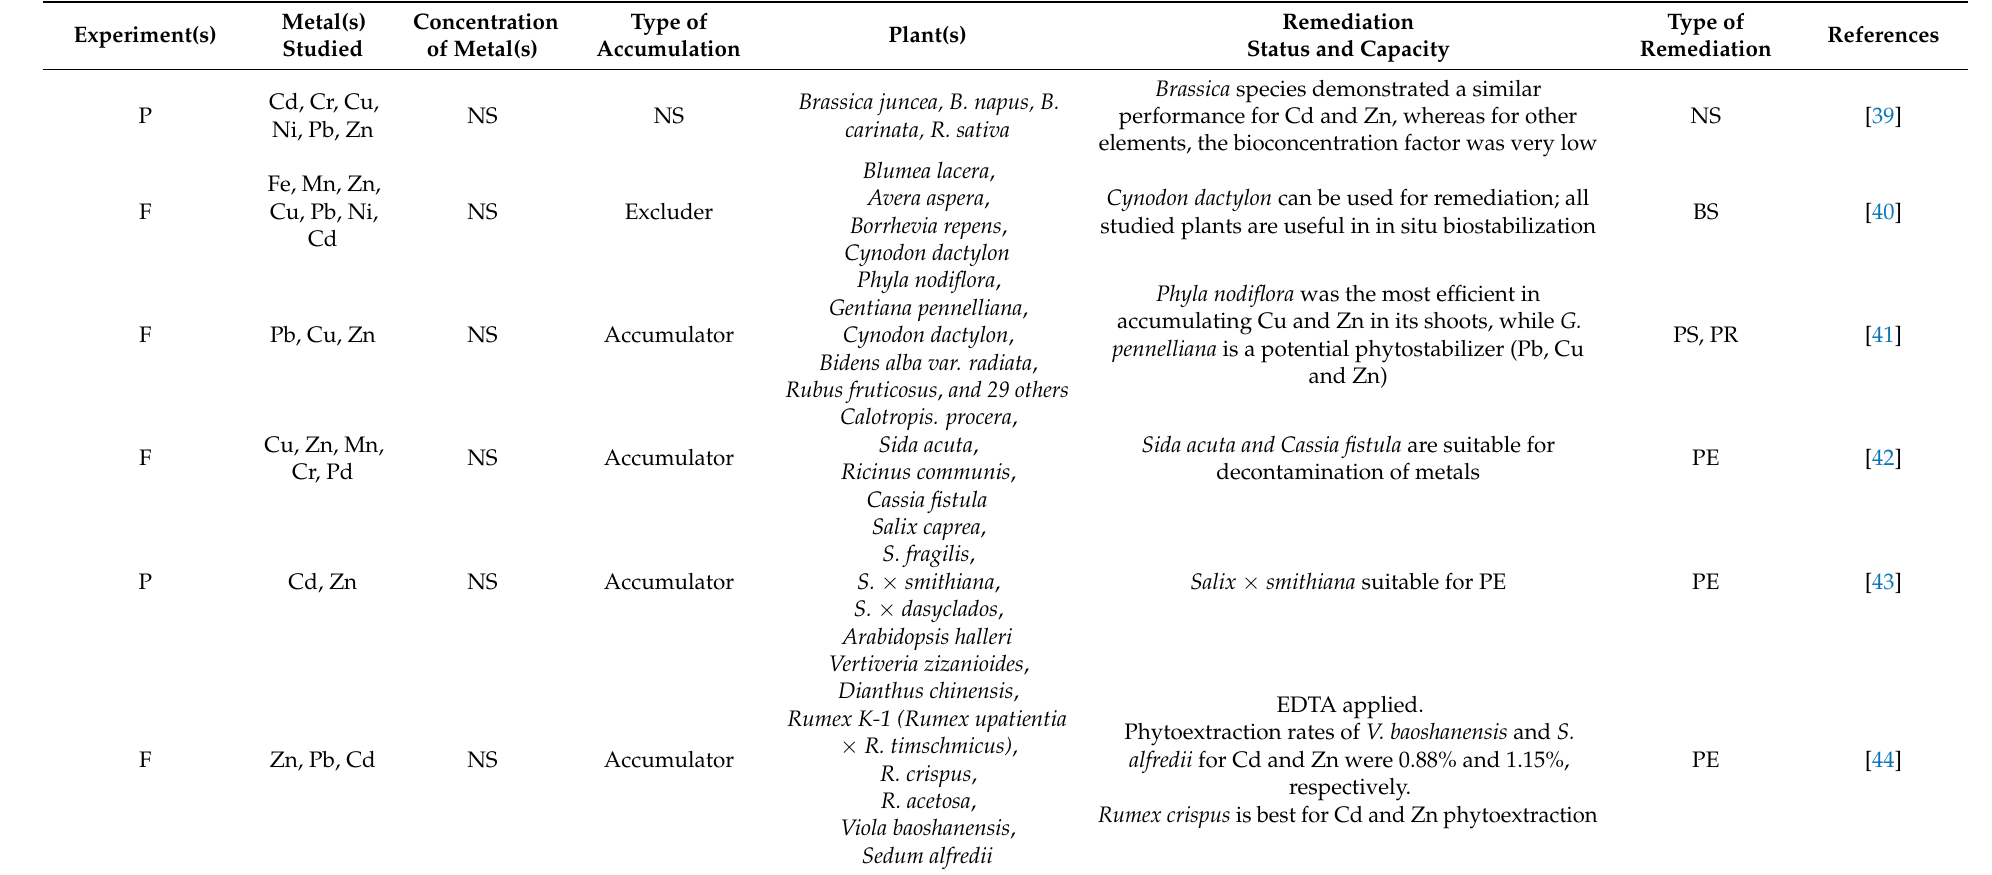
Table 1. List of metal(loid)s accumulating, excluding and hyperaccumulating plant species studied for the substrate remediation under non-spiked soil